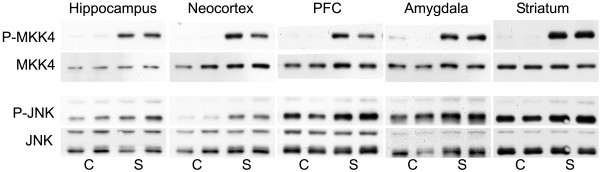
Swim stress-induced phosphorylation of MKK4, JNK1 and JNK2/3 in brain regions. Representative immunoblots are shown. In the JNK blots, the lower band corresponds to the 46 kD JNK1 isoform, while the upper band represents the (unseparated) 54 kD JNK2 and 3 isoforms. Abbreviations as in the legend to Fig. 1.